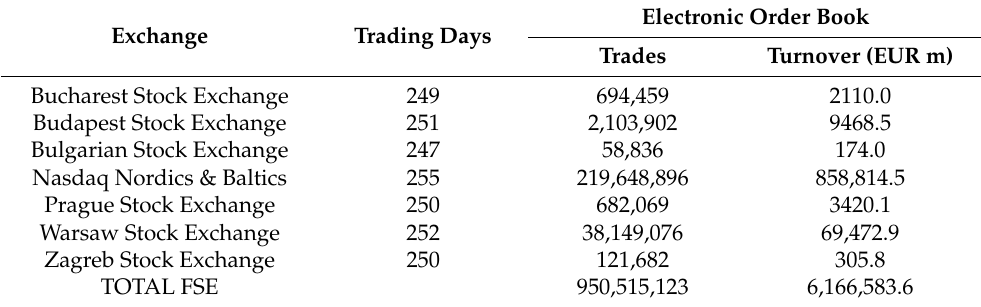
Table 2. Total bond and money market instruments